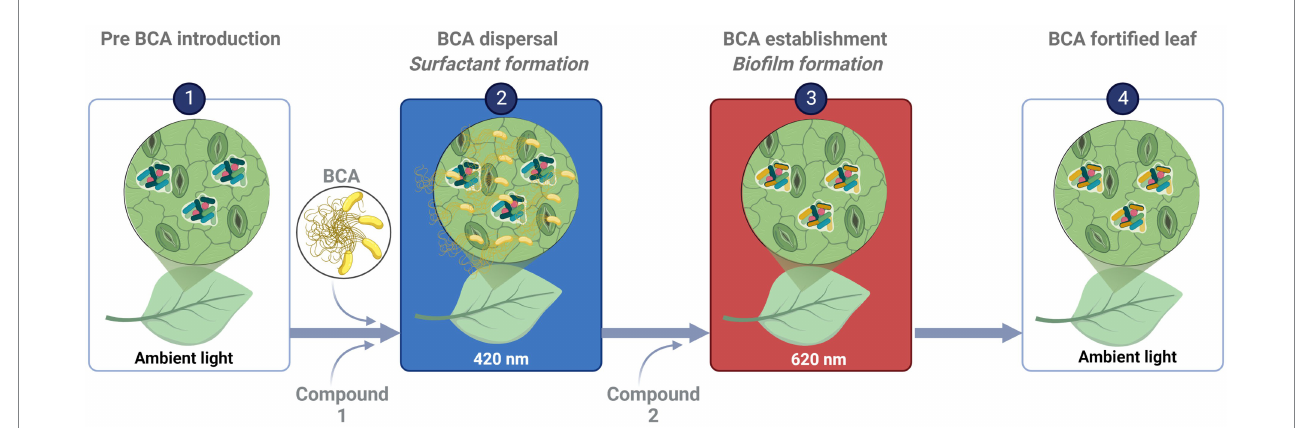
FIGURE 5 Schematic diagram illustrating putative areas of application for biocontrol agents (BCA). (Illustration: B. Alsanius; “Created with BioRender.com.” agreement number